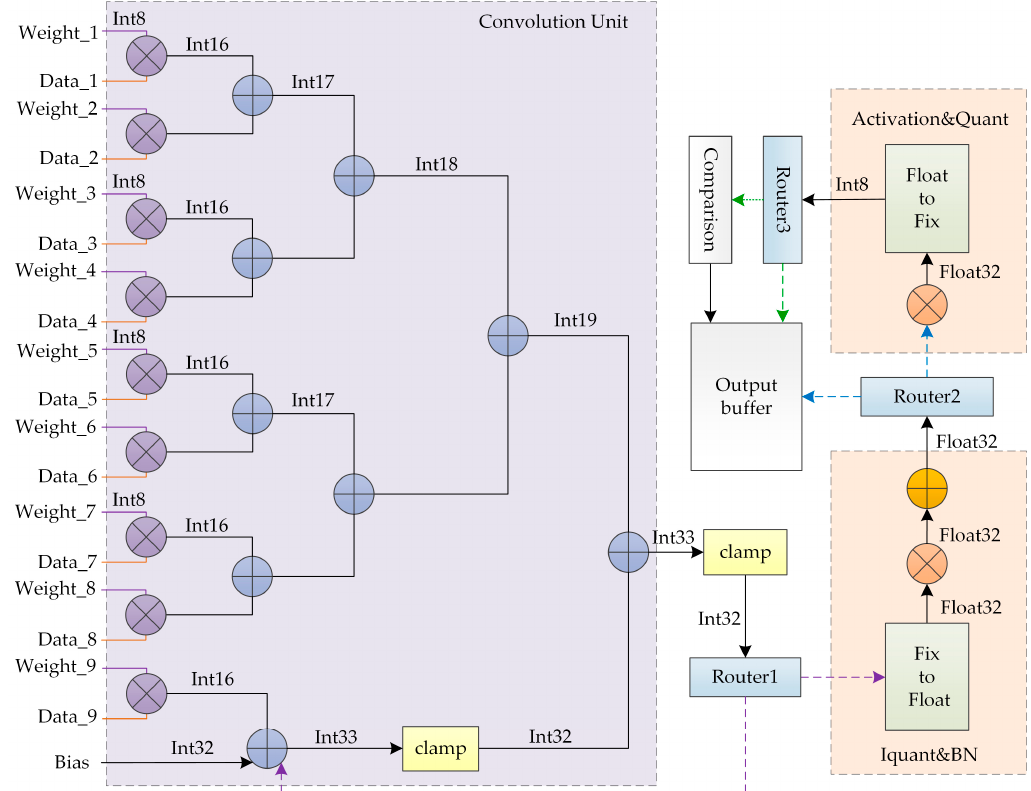
Figure 9. The architecture of the proposed processing engine (PE).